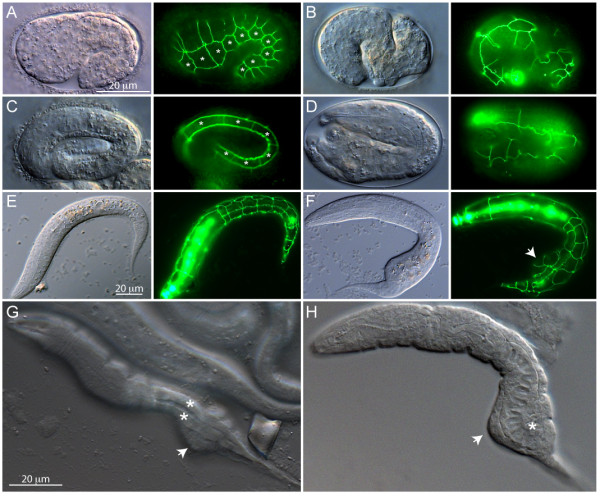
Hypodermal cell defects in ten-1(ok641) embryos. All animals shown are ten-1(ok641) mutants carrying the ajm-1::gfp transgene, which allows the visualization of the adherence junctions that surround the hypodermal cells. (A) A 1.5-fold embryo that is developing normally. Note the seam cells indicated by asterisks, and the ongoing hypodermal cell fusions on the dorsal side (discontinuous lines of GFP expression). (B) An example of a 2-fold embryo in which the posterior half has developed abnormally. Note the poorly organized pattern of ajm-1::gfp expression. (C) An early 3-fold stage embryo that is developing normally. Note the evenly spaced seam cells (asterisks) and the symmetrical distribution of the ajm-1::gfp pattern. (D) An early 3-fold embryo in which the posterior half has developed abnormally. Note in particular the meandering and disorganized pattern of ajm-1::gfp distribution. (E) Ventral aspect of an L1 larva that has developed normally. Again, note the regular shapes of the hypodermal cells. (F) Ventral aspect of an L1 larva with a deformity in its posterior half, which corresponds to a misshaped hypodermal cell (arrow). (G) DIC image of a ten-1(ok641) L1 larva with focus on the two muscle quadrants with normal appearance (asterisks) in spite of the posterior deformity (arrow). (H) DIC image of a ten-1(ok641) L1 larva with focus on the deformed intestine (asterisks) and posterior deformity (arrow).